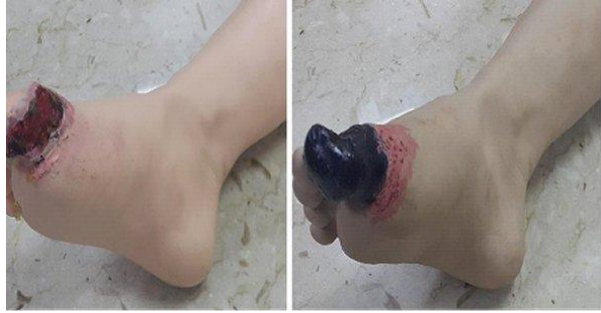
Figure 2: Photographs showing different types of moulage on